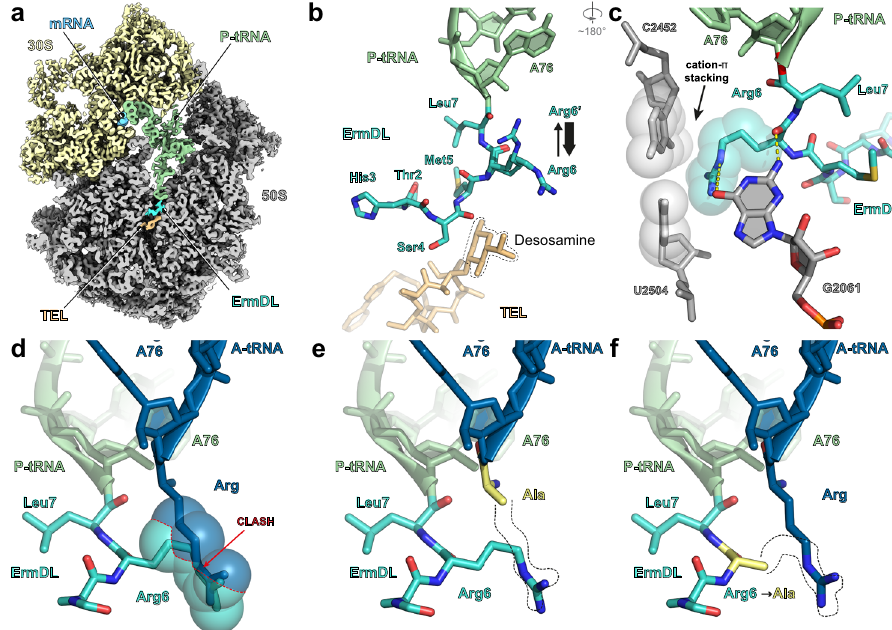
Fig. 3 Cryo-EM structure of ErmDL-TEL-SRC. a Transverse section of the cryo-EM map of the ErmDL-TEL-SRC with isolated densities highlighting the 30S (yellow) and the 50S (gray) subunits, P-site tRNA (green), mRNA (gray), ErmDL nascent chain (cyan) and telithromycin (TEL, orange). b Molecular model of the ErmDL nascent chain (cyan), P-site tRNA (green) and telithromycin (TEL, orange) from the ErmDL-TEL-SRC. The desosamine sugar of TEL is highlighted with dashed line and the alternative conformations of Arg6 are shown with weighted arrows indicating relative stoichiometries based on density. c Interactions of Arg6 of ErmDL with 23S rRNA, including stacking interaction with the U2504-C2452 base pair (arrowed). Dashed lines to G2061 indicate potential hydrogen bonding with Arg6. d Superimposition of the ErmDL-TEL-SRC with an A-site Arg-tRNA in silico mutated from the ErmBL A-site Lys-tRNA (blue, PDB 5JTE) 28 , illustrating that Arg6 of ErmDL nascent chain clashes (indicated by spheres) with the Arg side chain of the accommodated A-site tRNA. e , f In silico mutations of e A-site tRNA to Ala (based on Phe-tRNA from pre-attack state PDB ID 1VY7) 31 , and f Arg6 to Ala mutation in ErmDL nascent